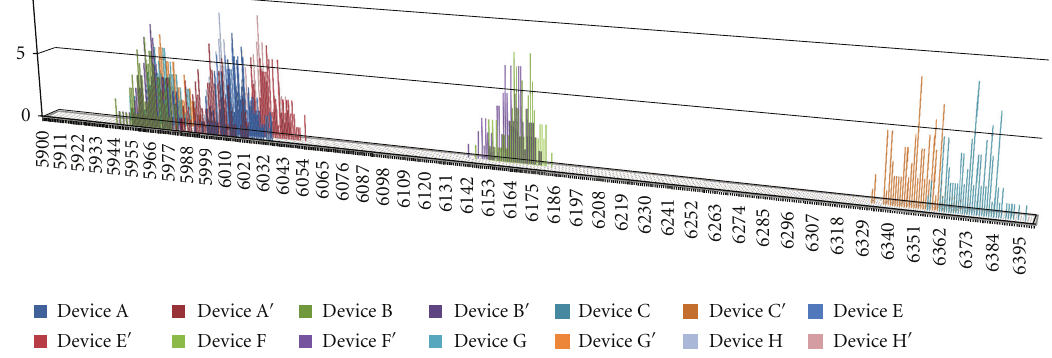
Figure 9: Enlarged presentation of the Hamming distance distribution of T D relative to ρ X and ρ